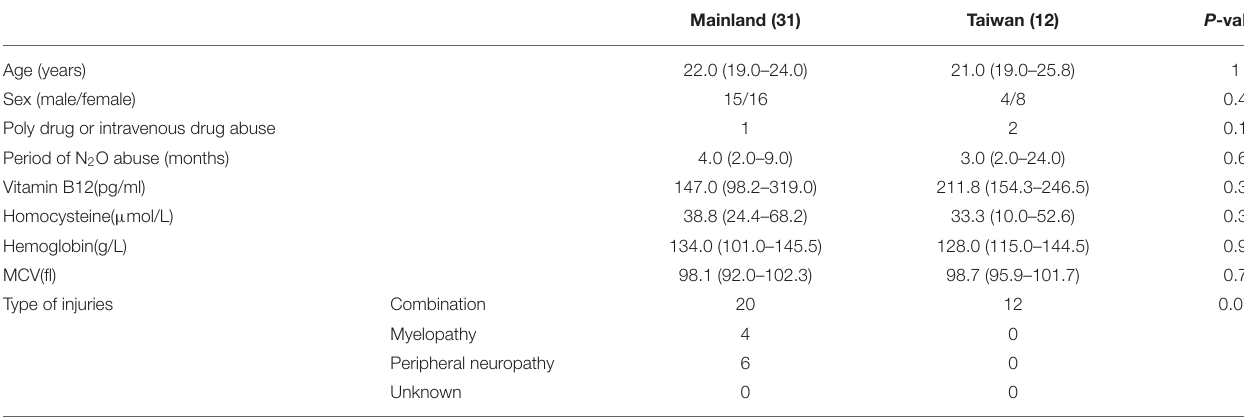
TABLE 3 | Comparison of demographic and clinical features of Chinese people in mainland and